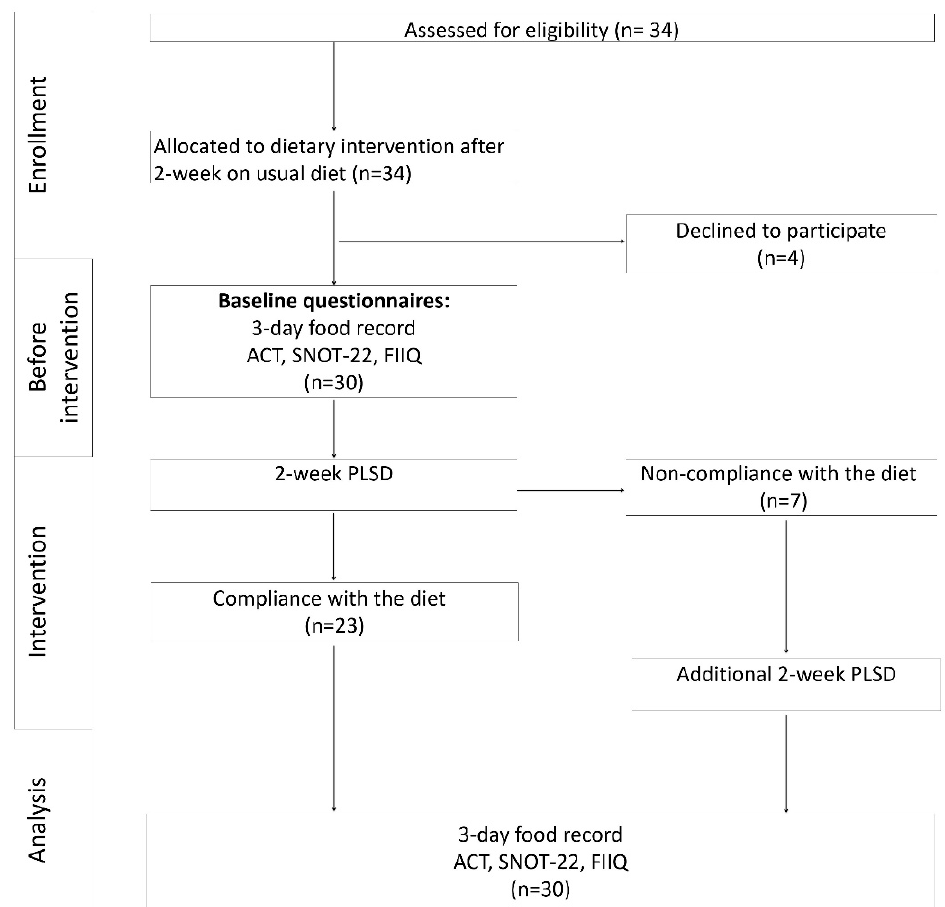
Figure 1. Study design. PLSD—personalized low salicylate diet, ACT—asthma control test, SNOT- 22—sino-nasal outcome test, FIIQ—four-item itch questionnaire.